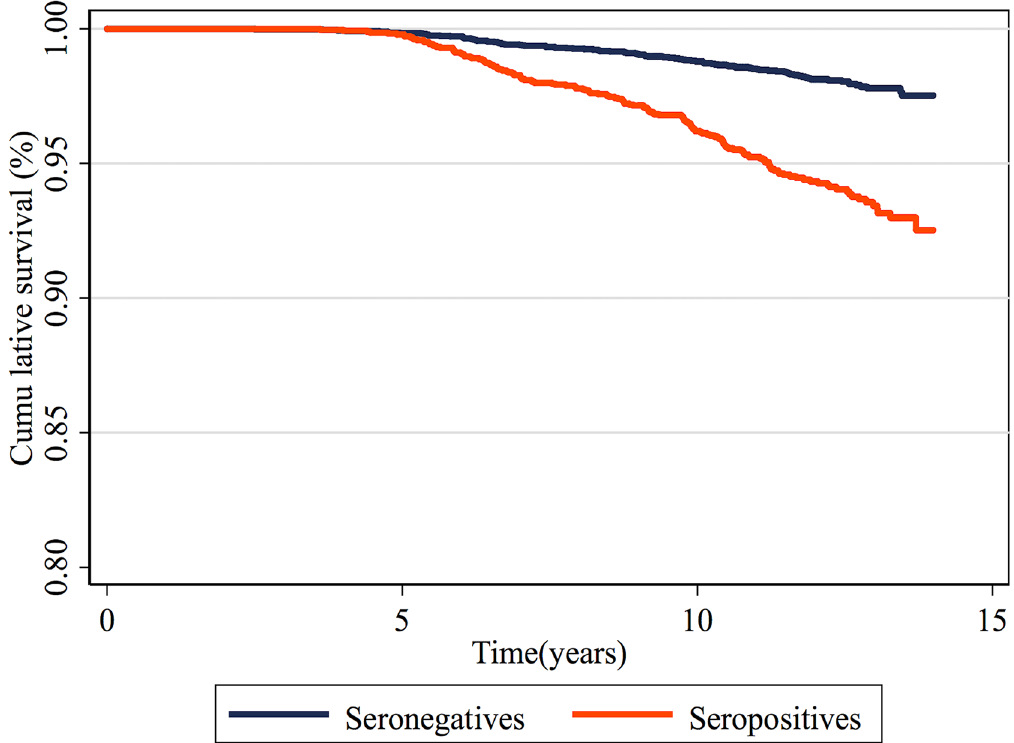
Fig 1. Cumulative survival of blood donors at FPS, S ã o Paulo, Brazil, from 1996–2000, by T . cruzi serology status.